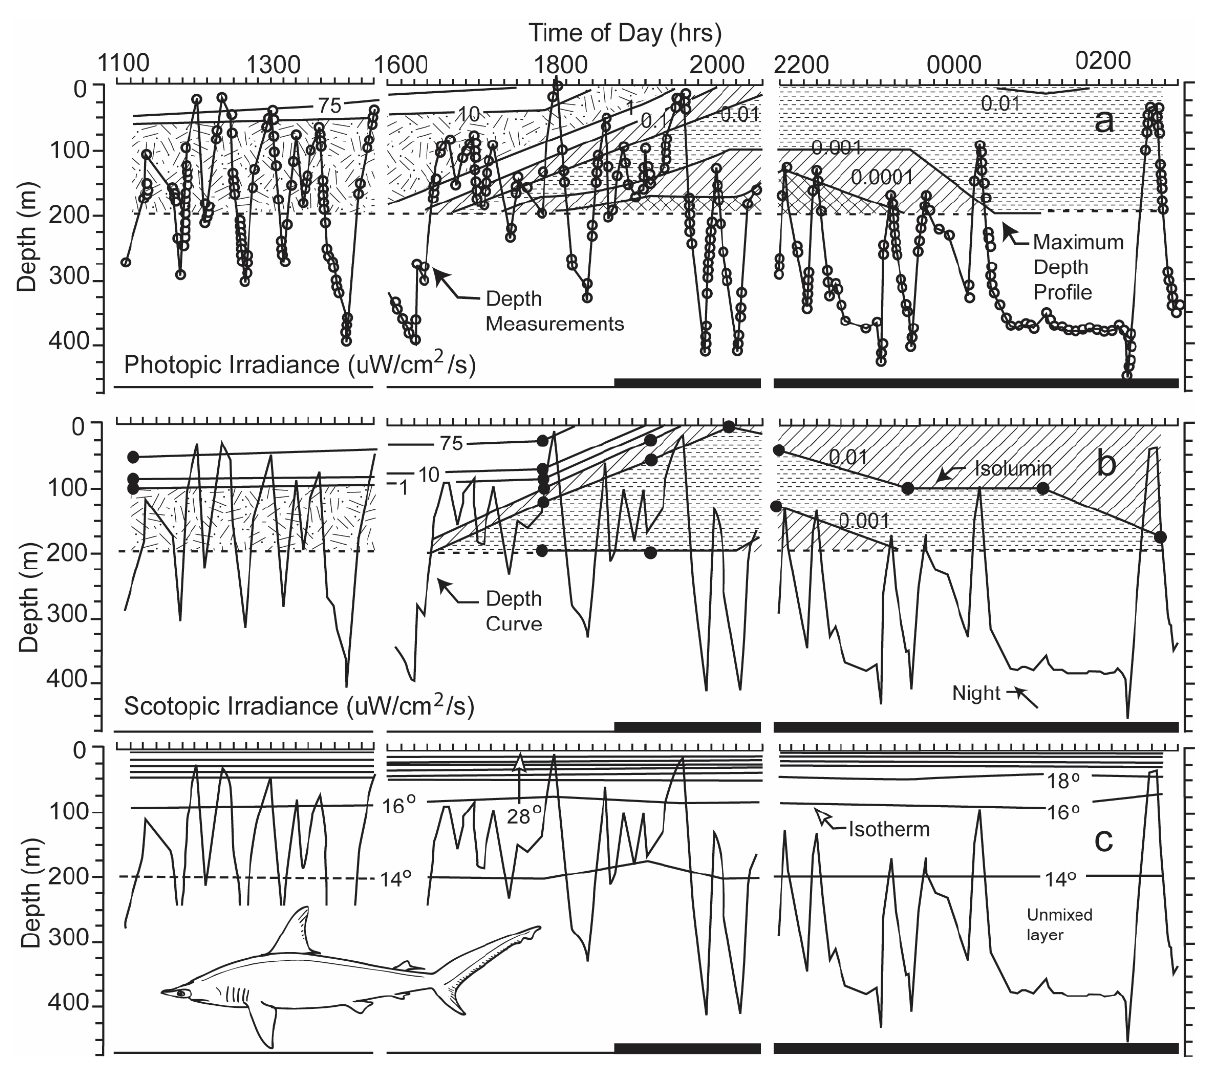
Figure 10. ( a ) The dive profile of a scalloped hammerhead superimposed on contours of irradiance, measured with a sensor emulating the shark’s photopic sensitivity; ( b ) dive profile superimposed irradiance contours emulating its scotopic sensitivity; ( c ) dive profiles superimposed on contours of water temperature [3]. Note that a transmitter, deployed near the tracking boat, could only be lowered to a depth of 200 m to obtain the irradiance and thermal iso-contours. With regard to scotopic irradiance, when the shark dived to a depth of 400 m at 23:30 hrs, the irradiance decreased from 0.01 to 0.001 uW/cm 2 /s over an increase of 100 m, giving a single log decrement for each increasing 100 m in depth. The scotopic irradiance would decrement 2 more log units over the 200 m further increase in depth. The irradiance level at 400 m would be 0.00001 uW/cm 2 /s, which is lower than the lowest